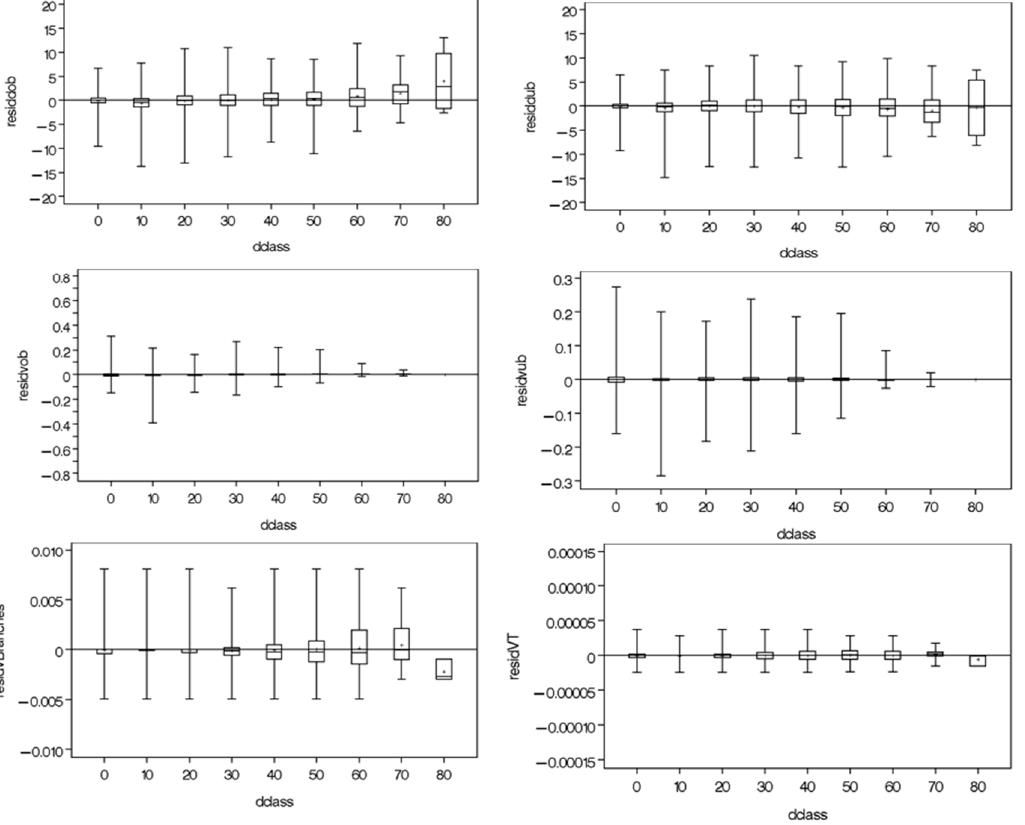
Figure 2. Box-and-whisker plots of the unweighted residuals for the variables of study against diameter class (cm) for Pinus cooperi. The boxes represent the interquartile ranges. The upper and lower ends of the whiskers represent the maximum and minimum height prediction errors respectively. where: d ob : diameter over bark (cm); d ub : diameter under bark (cm); v ob : merchantable volume over bark (m 3 ); v ub : merchantable volume under bark (m 3 ); V branches : coarse branches (>5 cm) volume (m 3 ); V total : total tree volume (m 3 ).